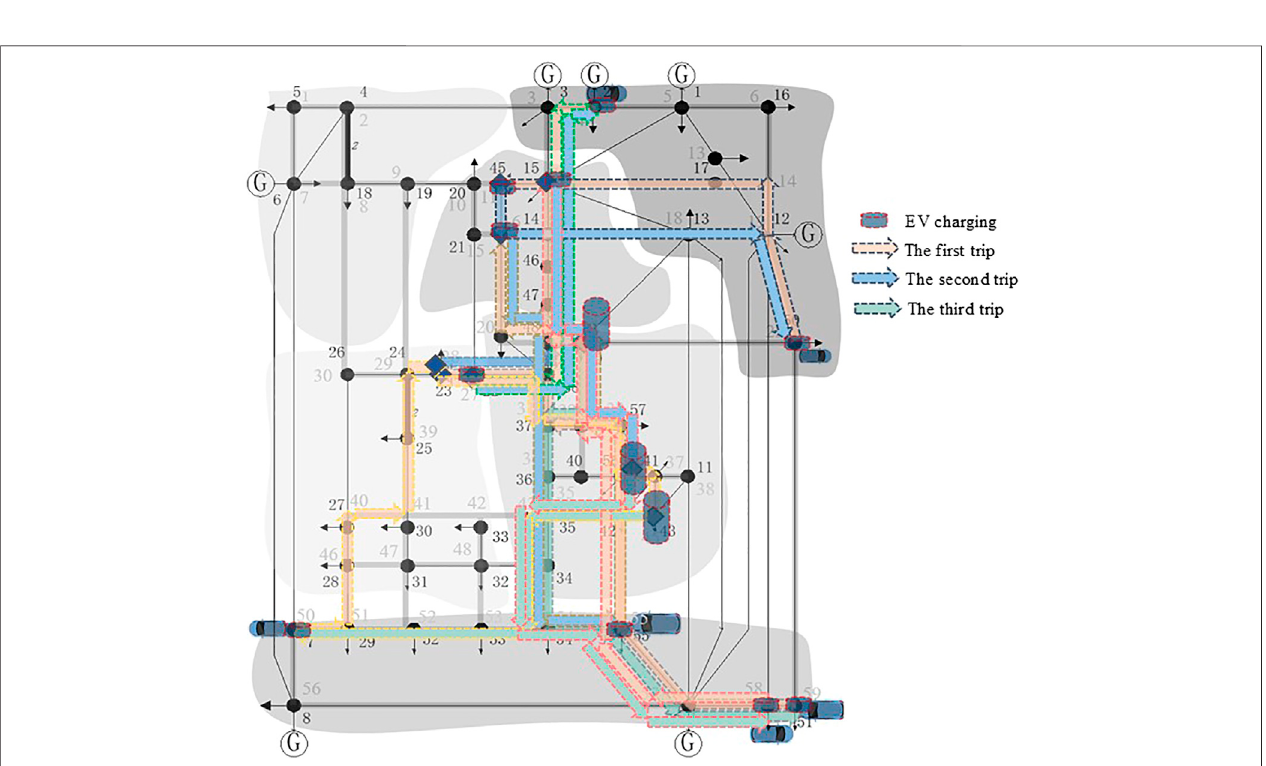
FIGURE 6 | Description of EVs ’ traveling trajectory and charging